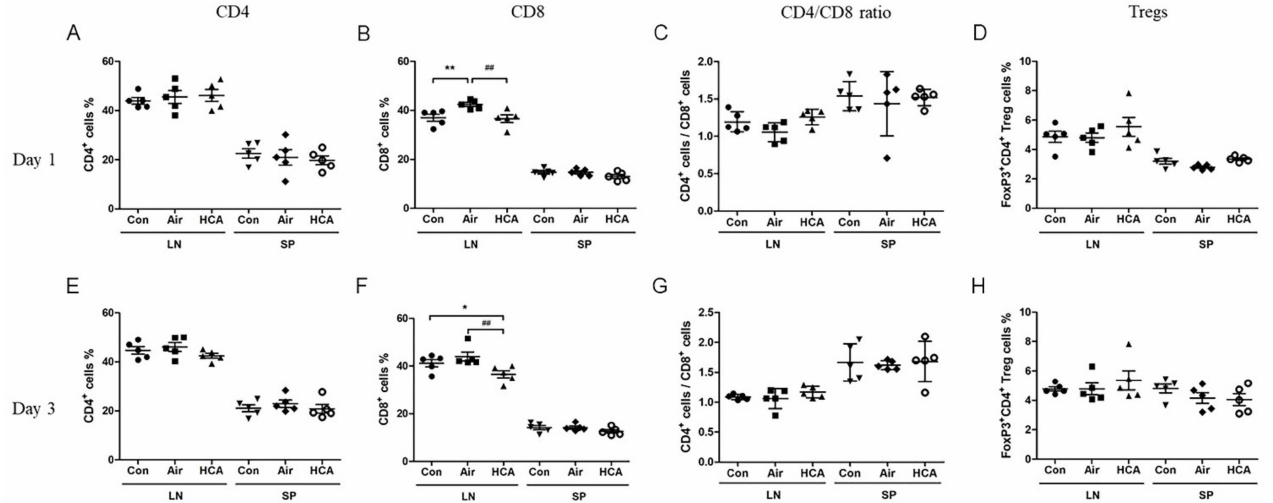
Figure 5. Immunophenotypes of draining lymph nodes and spleen T cells. The percentage of CD4 + ( A ), CD8 + ( B ), CD4/CD8 ratio ( C ), and regulatory T cells (Treg) ( D ) on day 1 and CD4 + ( E ), CD8 + ( F ), CD4/CD8 ratio ( G ), and regulatory T cells (Treg) ( H ) on day 3 after allogeneic transplan- tation were analyzed by flow cytometry, respectively. ( n = 5 mice/group). * p < 0.05; ** p < 0.01 compared with Con group; ## p < 0.01 compared with Air